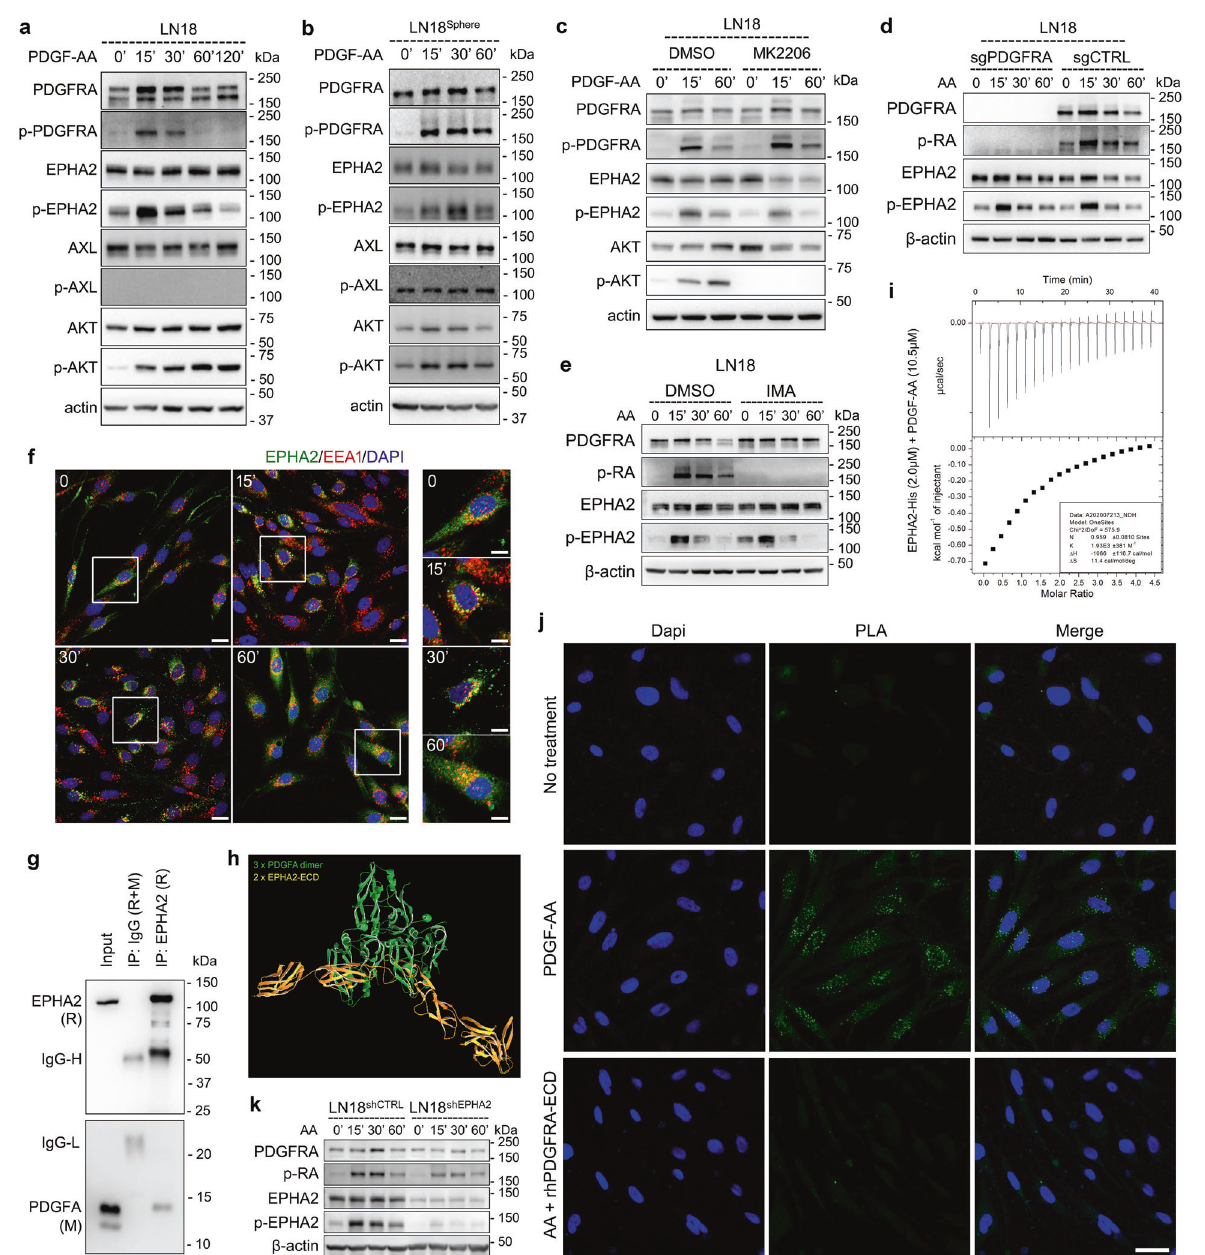
Fig. 2 PDGFA activates EPHA2 in a PDGFRA-independent manner in GBM cells. a PDGFA-induced temporal expression of indicated proteins in LN18 cells examined by western blotting. β -actin is used as loading control. b PDGFA-induced temporal expression of indicated proteins in LN18 Sphere examined by western blotting. c PDGF-A-induced temporal expression of indicated proteins in LN18 cells pre-treated with DMSO and MK2206. d PDGFA-induced temporal expression of indicated proteins in LN18 cells infected with lentivirus containing control sgRNA or sgRNA targeting PDGFRA. e PDGFA-induced temporal expression of indicated proteins in LN18 cells pre-treated with vehicle or IMA. f Representative immuno fl uorescence images stained by antibodies targeting EPHA2 and EEA1, respectively. DAPI is used to label nuclei. Scale bar = 10 μ m for large four panels and 5 μ m for small four panels. g Co-immunoprecipitation and western blotting of EPHA2 in PDGFA-treated LN18 cells. h Interaction simulation of three-dimension structure of PDGFA and EPHA2 extracellular domain. i Interaction thermodynamics of recombinant human EPHA2 extracellular domain and recombinant human PDGF-AA using Microcal iTC200. j Proximity ligation assay using LN18 cells without treatment, treated with PDGFA for 15 min, or pre-treated with recombinant PDGFRA extracellular domain followed by PDGFA treatment for 15 min. The cells is counterstained with Dapi (blue) to mark nuclei. Green dot signals represent interaction between EPHA2 and PDGFA. Scale Bar = 25 μ m. k PDGFA-induced temporal expression of indicated proteins in LN18 cells infected with lentivirus containing control shRNA or shRNA targeting